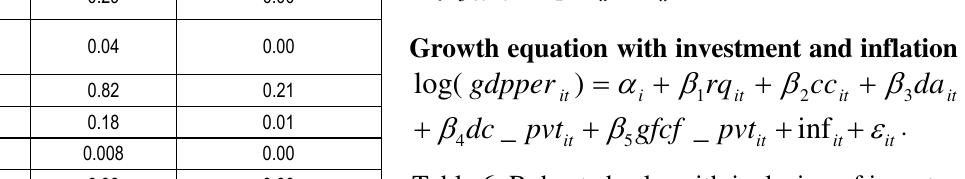
Table 6. Robust checks with inclusion of